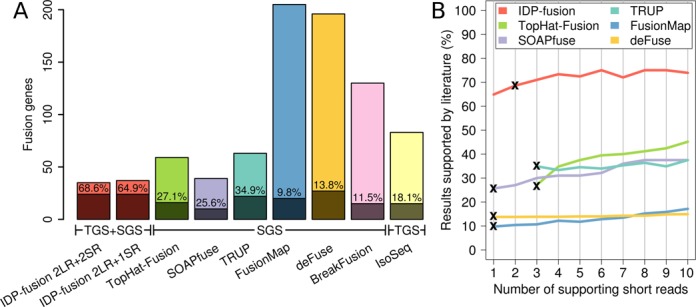
Precisions of fusion gene detections by IDP-fusion, six SGS-only methods and a TGS-only method. (A) The total numbers of fusion genes detected from MCF-7 cells by IDP-fusion, six SGS-only methods and Iso-Seq (TGS-only method) and the corresponding numbers of the gold standard fusion genes are shown by stacked bars. The precisions are also shown as the rates of the gold standard fusion genes detected. Two modes of IDP-fusion, using either ≥2 supporting long reads (LR) and ≥1 supporting short read (SR) or ≥2 supporting long reads and ≥2 supporting short reads (default settings) are compared with six SGS-only methods that were run under their default settings and Iso-Seq method requiring ≥5 full-length long reads. (B) The precision of fusion gene detection by IDP-fusion is higher than SGS-only methods, regardless of increase of the minimum numbers of supporting short reads. The precision of the default setting for each method is labeled by ‘x’. Note that BreakFusion is not shown because the software does not output the number of supporting reads for each fusion site.